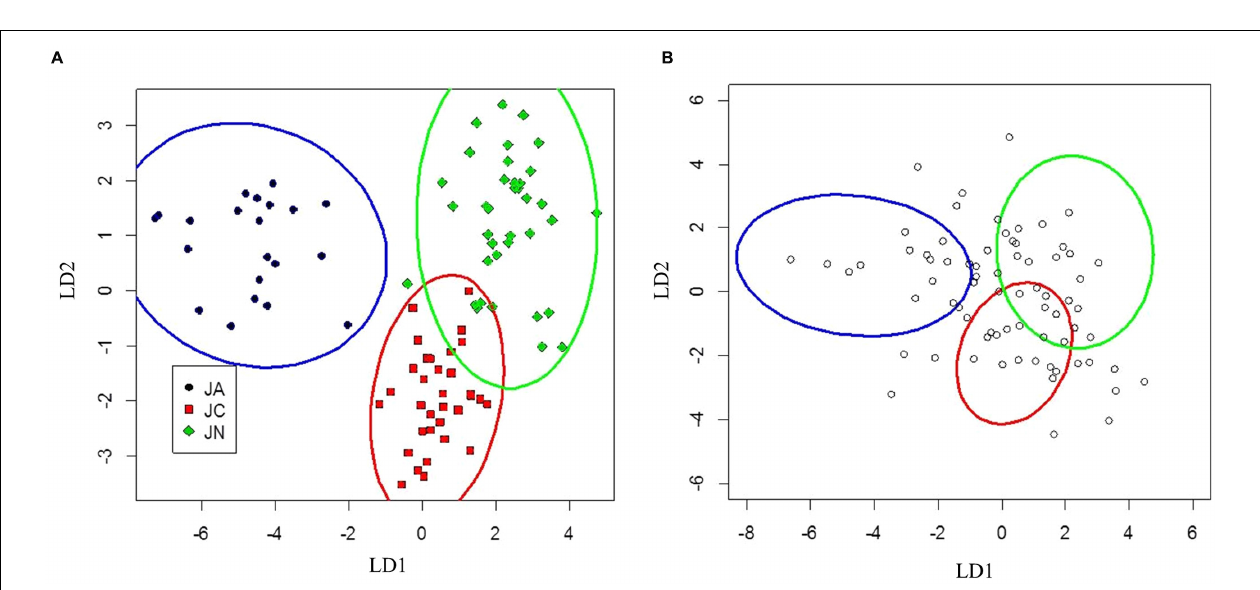
FIGURE 3 | Canonical discriminant analysis separating Juglans ailantifolia Carr. var. cordiformis (JA), J. cinerea L. (JC), and J. nigra L. (JN) based upon vegetative characteristics (A) . J. × bixbyi Rehd. (JX) individuals (open circles) were applied to the parameter space using the discriminant function determined from (A) . (B) Pure species are enclosed by 95% confidence interval ellipses. LD1 and LD2 refer to the first and second discriminant axes, respectively.